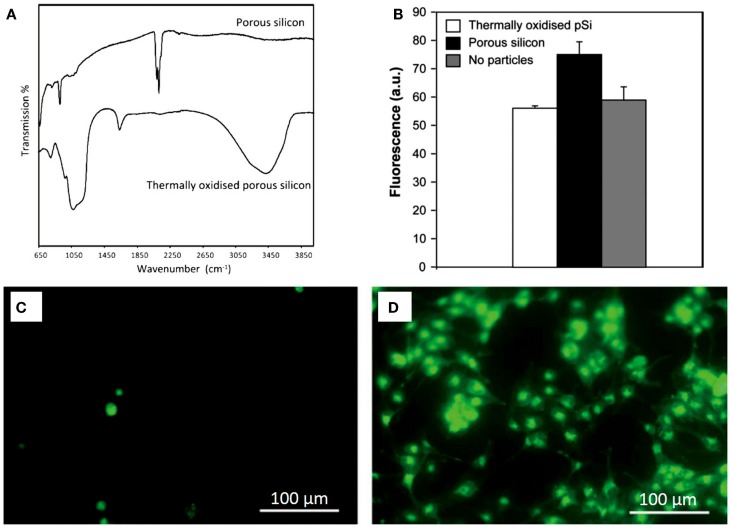
(A) Transmission FTIR spectra of PSi and thermally oxidized PSi. (B) Detection of residual oxygen species with PSi particles in 24 h-incubation of human lens epithelial cells on a non-treated PSi, and on a thermally oxidized PSi. Results are expressed as mean fluorescence units at 100 s integration time point. Fluorescence intensity is significantly higher for PSi particles in comparison to thermally oxidized PSi particles and to the no particles samples. (C) Twenty-four hours incubation of human lens epithelial cells on a non-treated porous silicon membrane, and (D) on a thermally oxidized porous silicon membrane. Reprinted from Low et al. (2010).